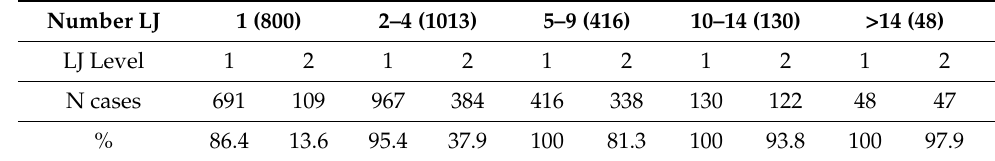
Table 1. Number of thunderstorms (in parenthesis in the first row) with a single-LJ, between 2 and 4 LJs, 5 to 9 LJs, 10 to 14 LJs, and more than 14 LJs. Each category has two columns, with the number (and the percentage with respect to the total Ls of the selected category) of thunderstorms with at least one LJ of Level 1 (left) and Level 2 (right). Note that, except in the single-LJ case, the numbers are not